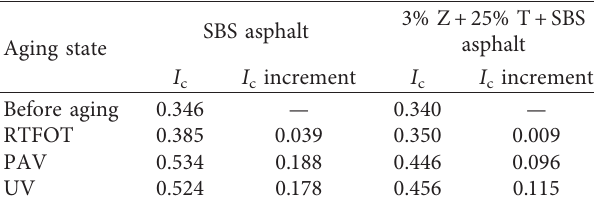
Table 4: Calculation results of asphalt colloid instability index.